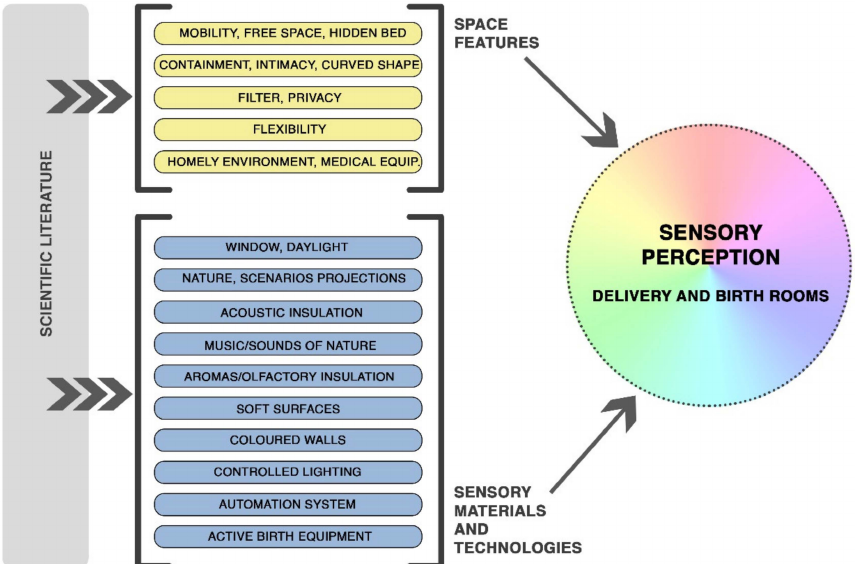
Figure 2. Space features and sensory materials and technologies that can affect the sensory perception in the sensory delivery and birth